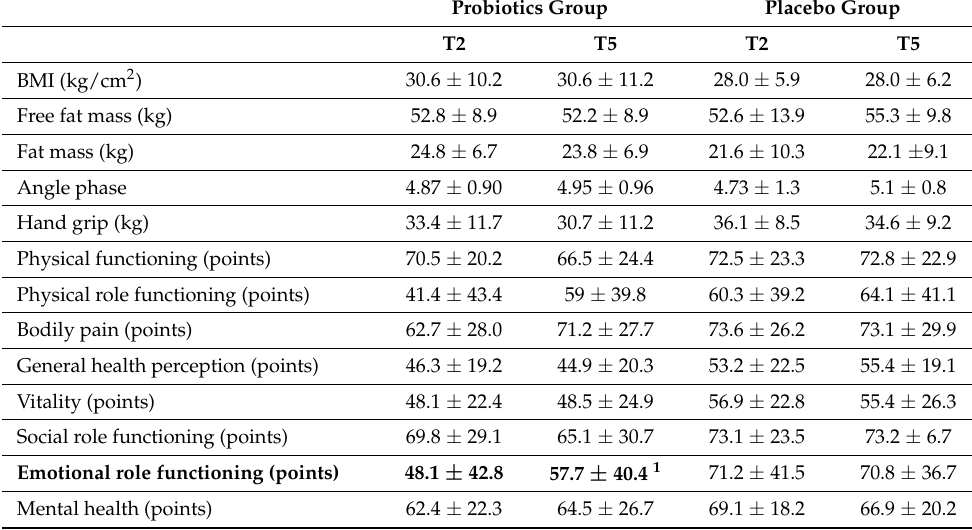
Table 6. Nutritional assessment and quality of life (SF36 items). Values are presented as mean ± SD.